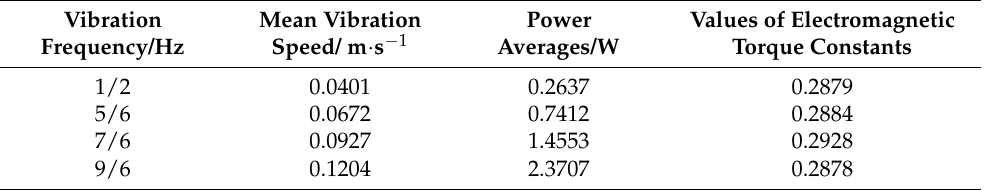
Table 1. Energy recovery test data.